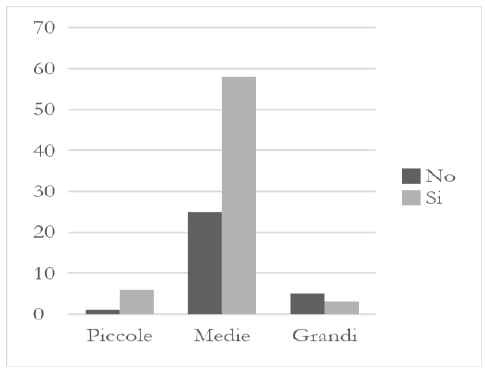
Figure 12. Relation between dimensions and